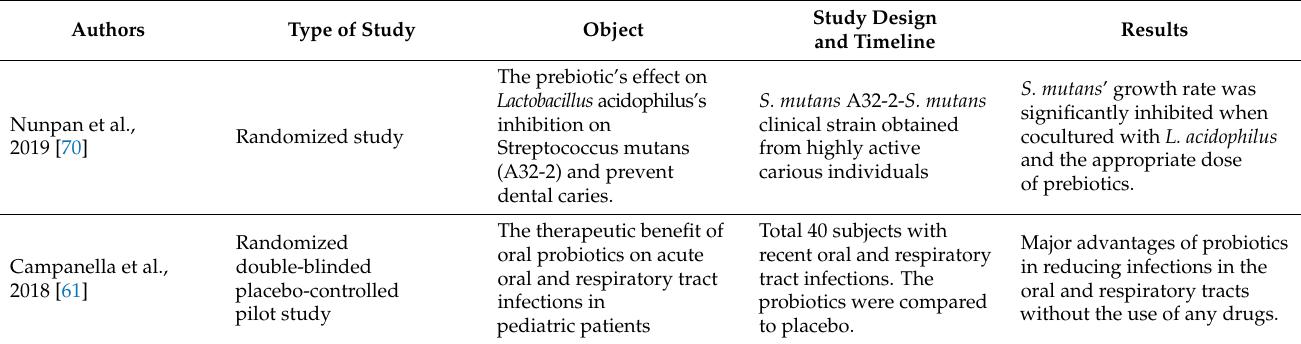
Table 5. Included studies that explored the influence of probiotics and prebiotics on dental